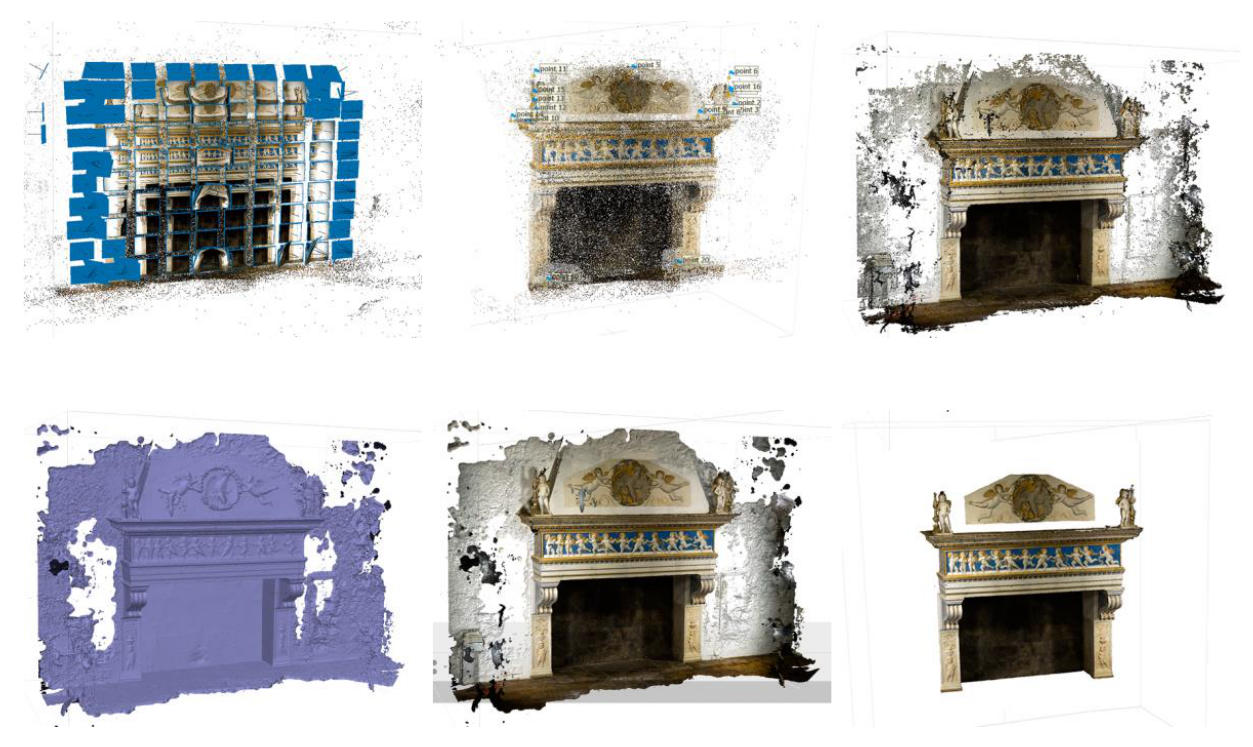
Figure A1. The illustration of all digitization and mesh constructing steps.